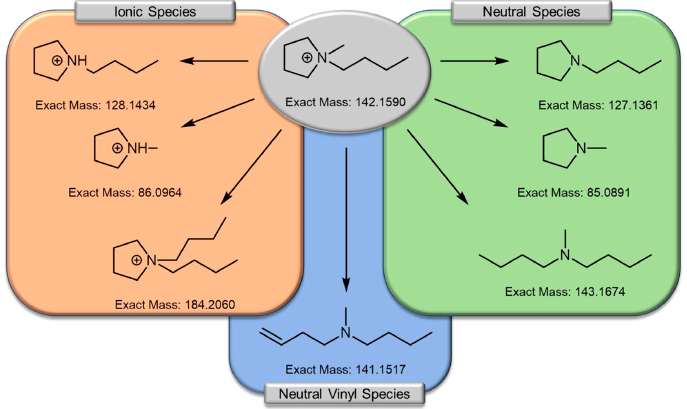
Figure 7. Graphical summary of the range of ionic and neutral decomposition species of C 4 mpyr- cation. The ionic species (orange box) were identified by Pyschik et al. [176,177] while Kroon et